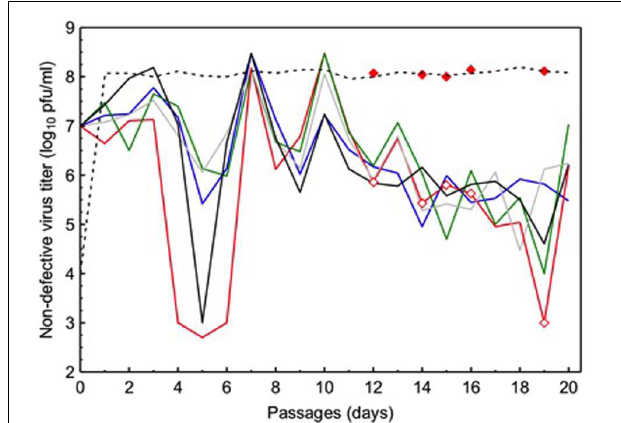
FIGURE 1 | Temporal dynamics of ordinary virus titers in five vesicular stomatitis virus (VSV) populations independently cultured for 20 passages under frequent co-infection of BHK-21 cells. Each solid line depicts titer data from an individual population (purple line: L1; red line: L2; green line: L3; gray line: L4; black line: L5). Open diamonds indicate time points when virus samples were isolated from lineage L2, and assayed for growth on cells at low multiplicity of infection (filled diamonds). Dashed line indicates typical growth ability of a VSV lineage founded by a full-length wild-type (WT) virus genotype, and passaged in the absence of